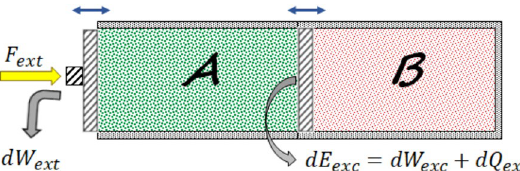
Figure 1. A classical gas A (system of interest) is in contact with another gas B (environment). The total system AB is insulated against heat from the surroundings. If the pressures of the gases are different from each other and the membrane is movable then work can be done on system A by system B through the